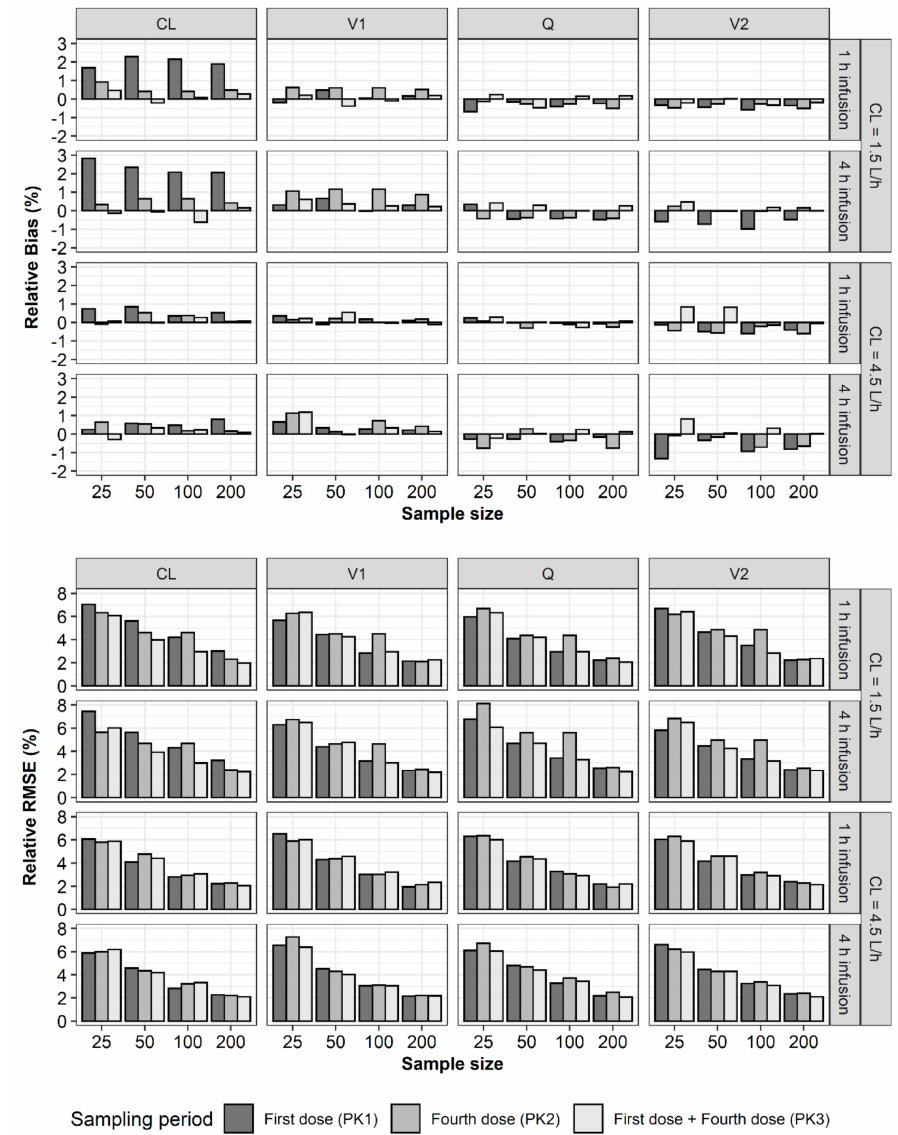
Figure 2. Relative bias ( upper ) and relative RMSE ( lower ) of structural pharmacokinetic parameters estimates for two-compartment model of vancomycin (CL—total clearance; V1—volume of the distribution of the central compartment; V2—volume of distribution for the peripheral compartment; Q—intercompartmental clearance between V1 and